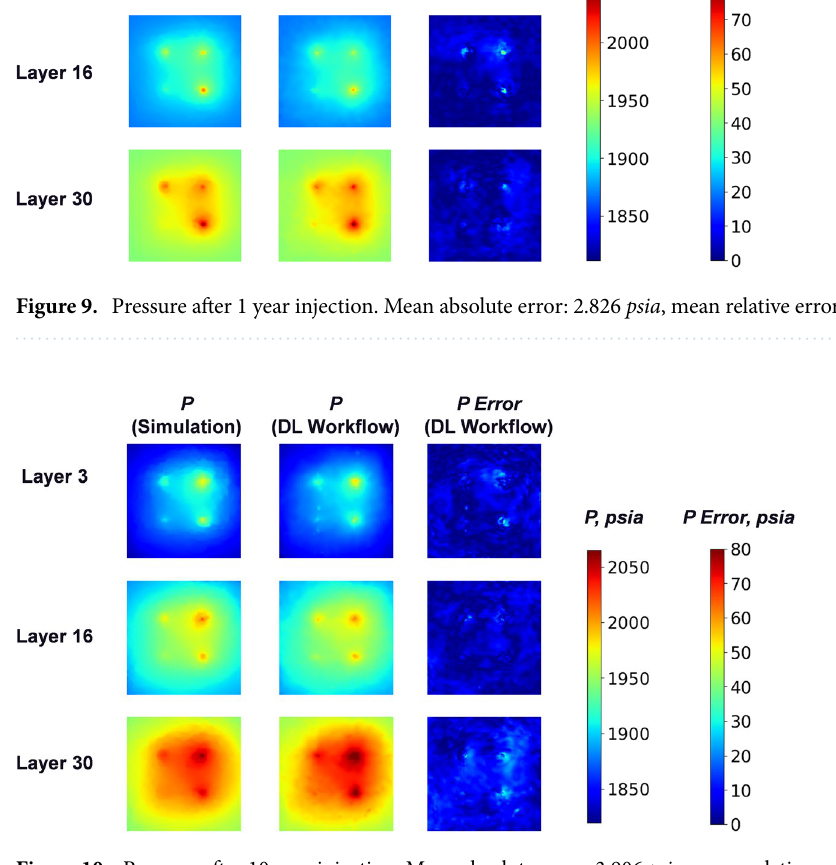
Figure 10. Pressure after 10 year injection. Mean absolute error: 3.906 psia , mean relative error: 0.202% .